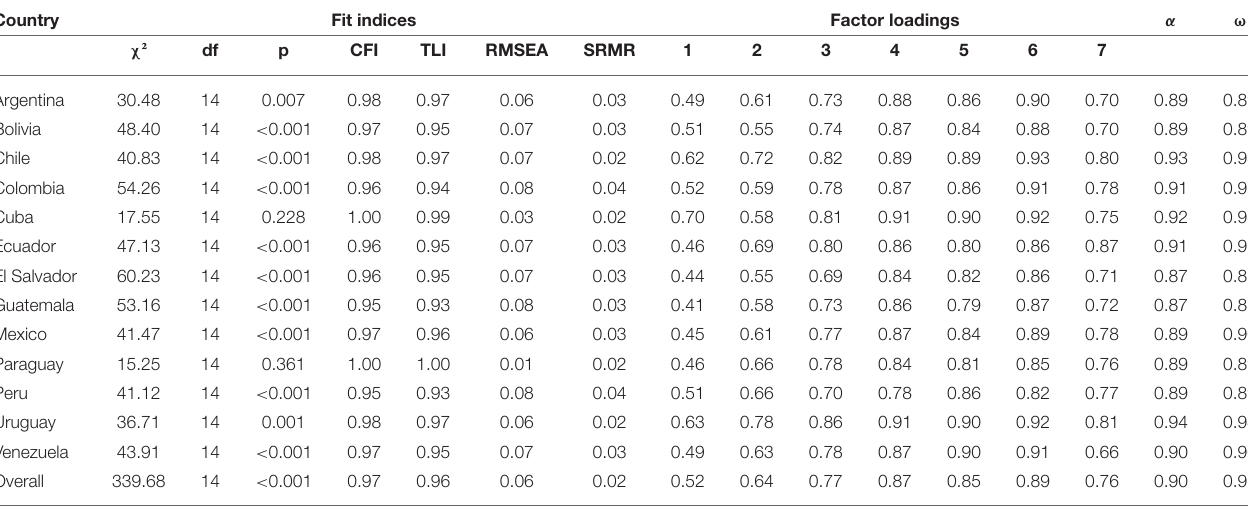
TABLE 5 | Single-group confirmatory factor analyses and internal consistency reliability of the COVID-VCBS.